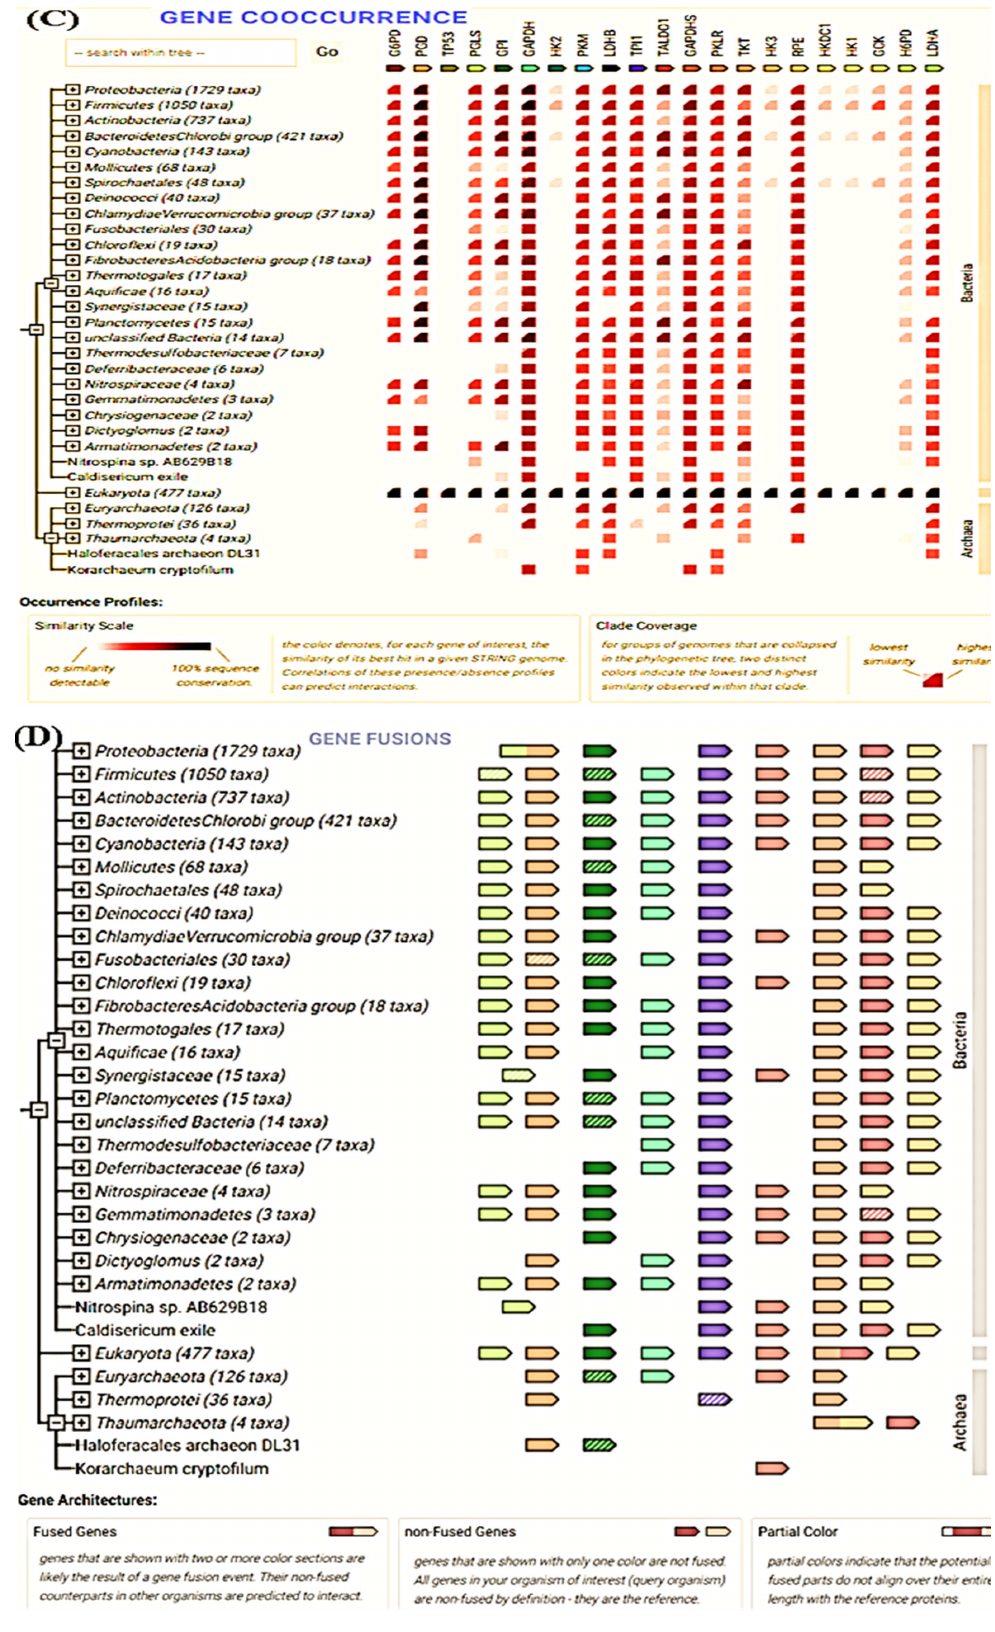
Figure 8. STRING analysis. ( A ) Network interactions, ( B ) Gene ‐ neighborhood, ( C ) Gene Co ‐ occurrence and ( D ) Gene fusion.